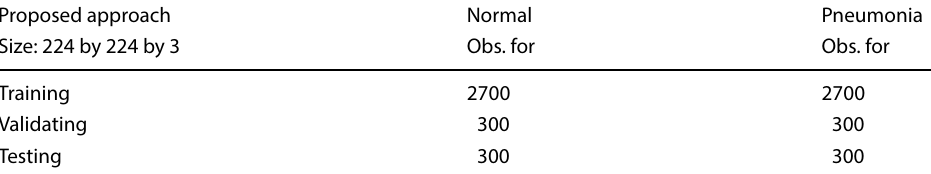
Table 2 The size of the training set, the validating set, and the test set for both